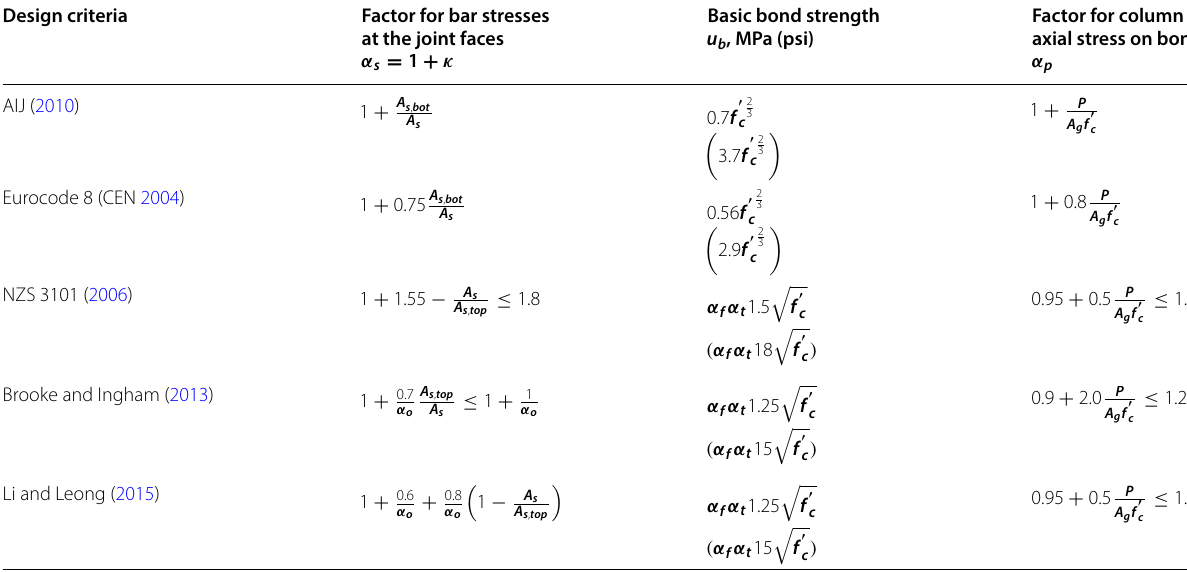
Table 1 Comparison of existing design equations for the minimum joint depth.